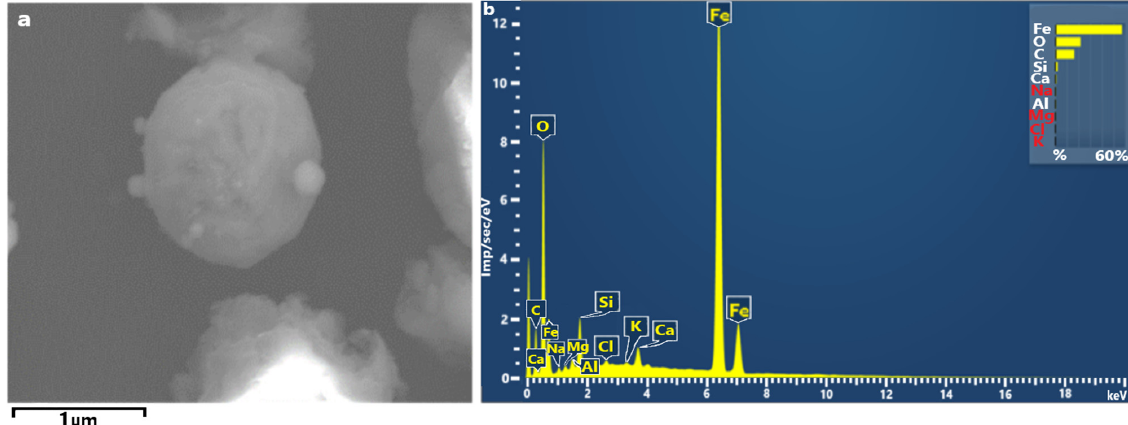
Figure 7. ( a ) SEM micrograph Fe-rich particles (magnification 6000×) and ( b ) their EDS spectrum.